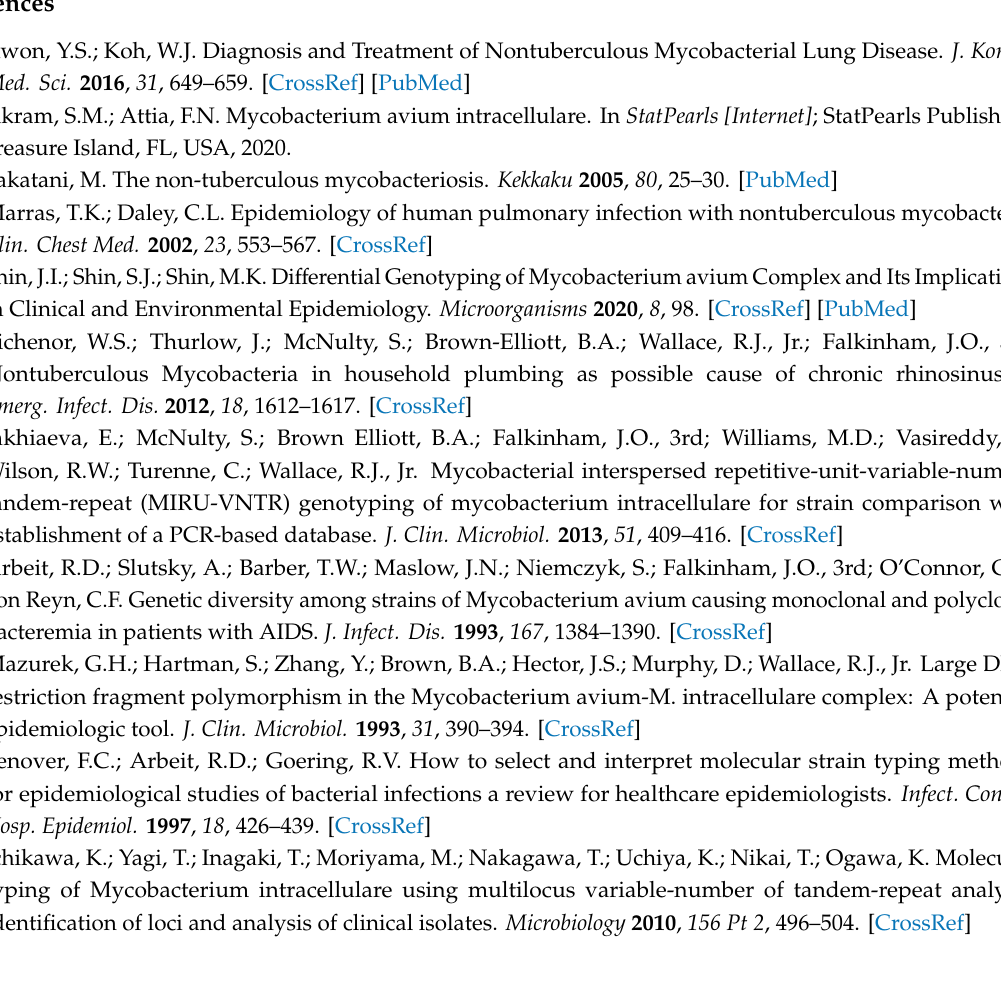
Table S1: Profiles of 16 VNTR loci on M. intracellulare isolated from Gyeongnam, Korea, and four countries used for minimal spanning tree analysis, Table S2: Profiles of 15 VNTR and 6 VNTR-MIRU loci on M. intracellulare isolated from Gyeongnam, Korea, and Seoul, Korea, and reference strains used for minimal spanning tree analysis. Author Contributions: Conceptualization, J.-W.Y. and M.-K.S.; methodology, H.-L.K.; software, D.-H.L.